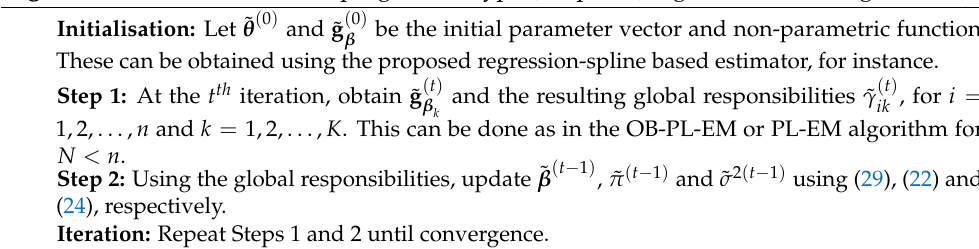
Algorithm 2 Profile likelihood plug-in EM-type (PL-p-EM) algorithm for fitting model